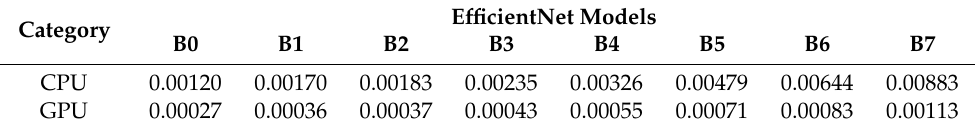
Table 7. Average calculation rate for EfficientNet experiments (s).